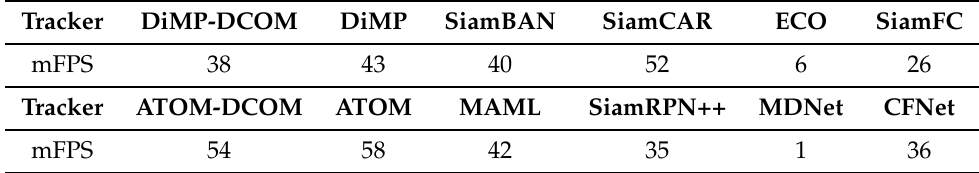
Table 7. The mean FPSs of our DiMP-DCOM and ATOM-DCOM and other state-of-the-art trackers on LaSOT.